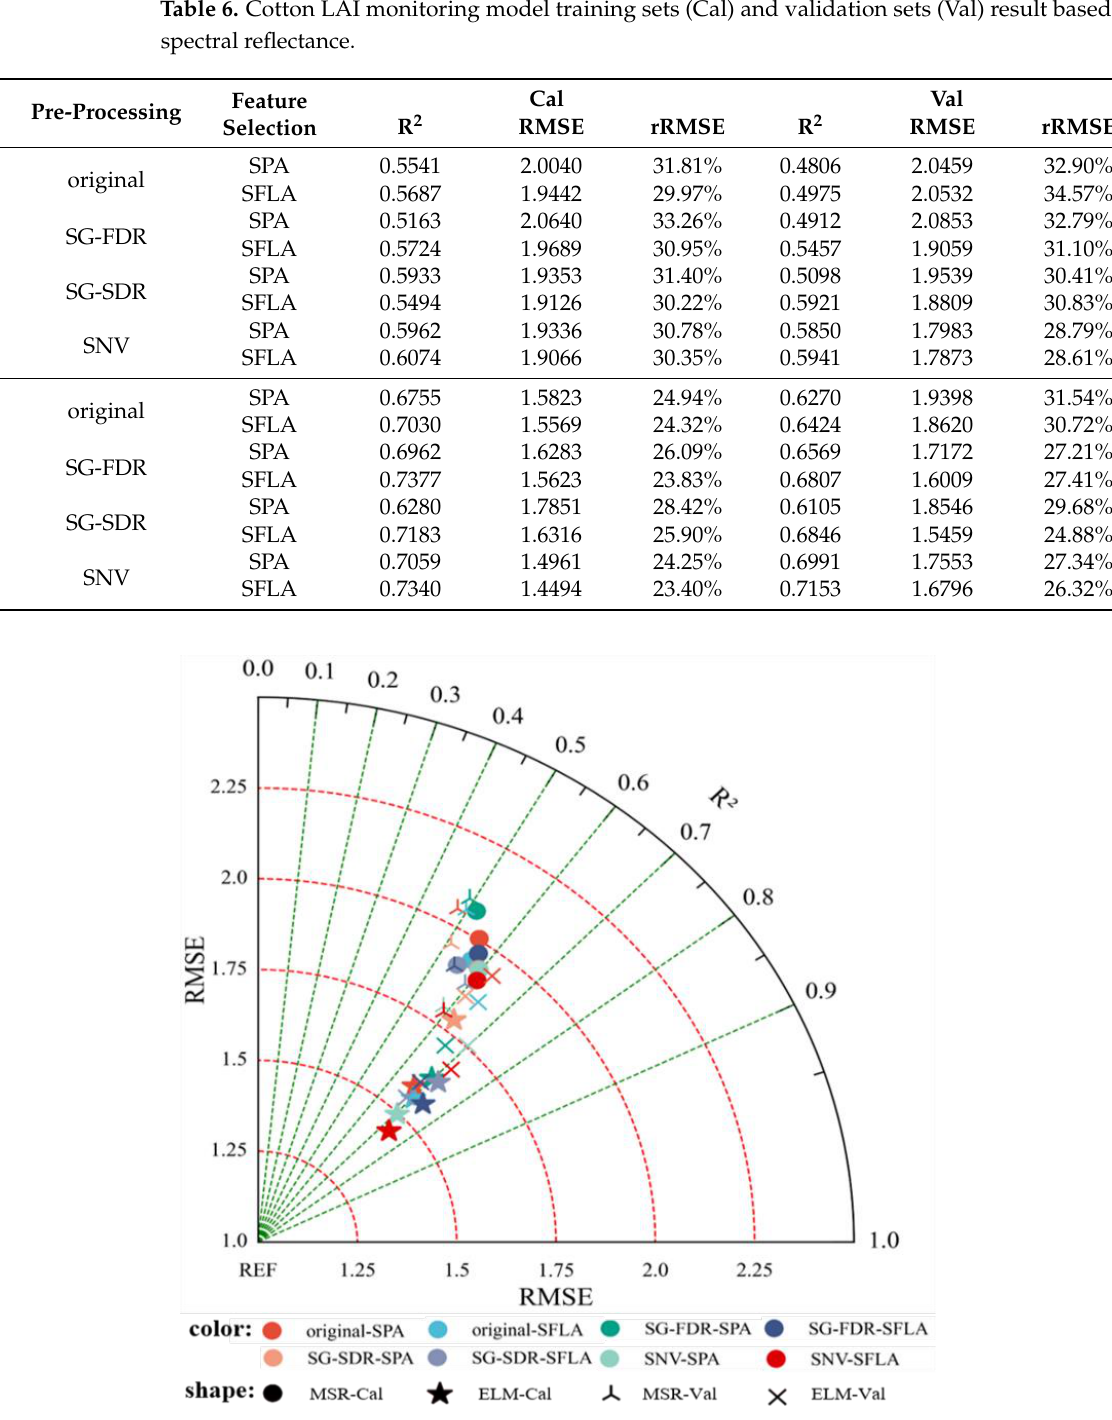
Table 6. Cotton LAI monitoring model training sets (Cal) and validation sets (Val) result based on spectral reflectance.